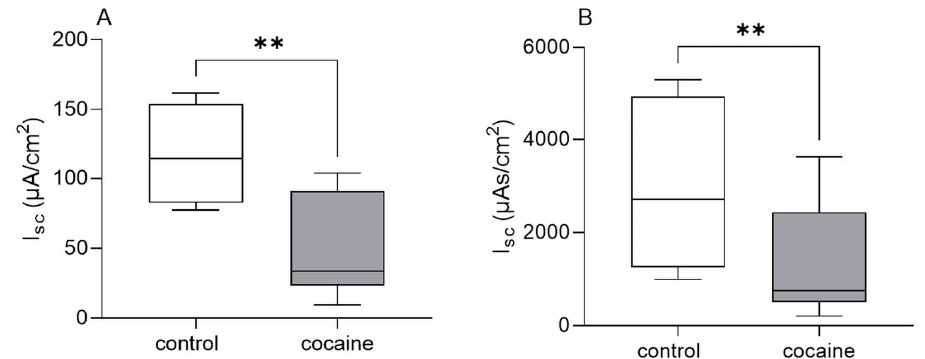
Figure 4. Effect of cocaine on intestinal epithelial secretion in vitro. Addition of cocaine (100 µ M) to the serosal compartment of Ussing chambers significantly reduced EFS-evoked maximal increase (amplitude) in I sc ( A ) and area under the curve ( B ) in guinea pig distal colonic mucosa–submucosa preparations compared to control tissues. Data shown are the medians with the 25th and 75th quartiles as a box plot and the minima and maxima as a whisker plot. N numbers (animals/preparations): four/eight for control, three/six for cocaine. Paired t-test ( A ) and Wilcoxon test ( B ), ** p < 0.01.